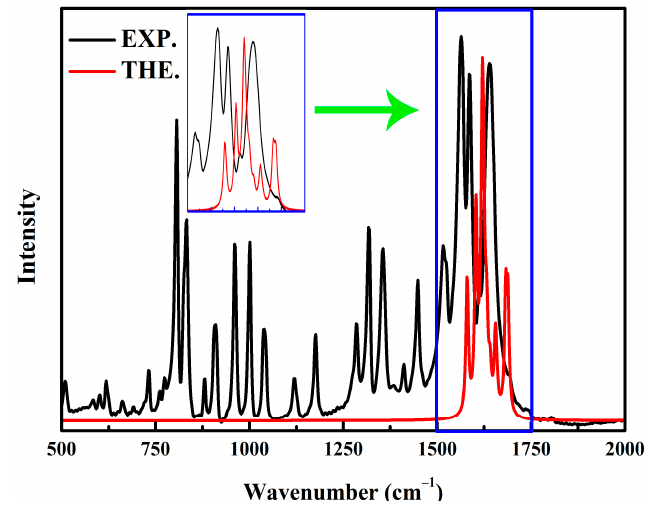
Figure 1. The experimental and theoretical IR spectra of DNTF molecules; the theoretical anharmonic IR spectra only include NO 2 asymmetric stretching modes.